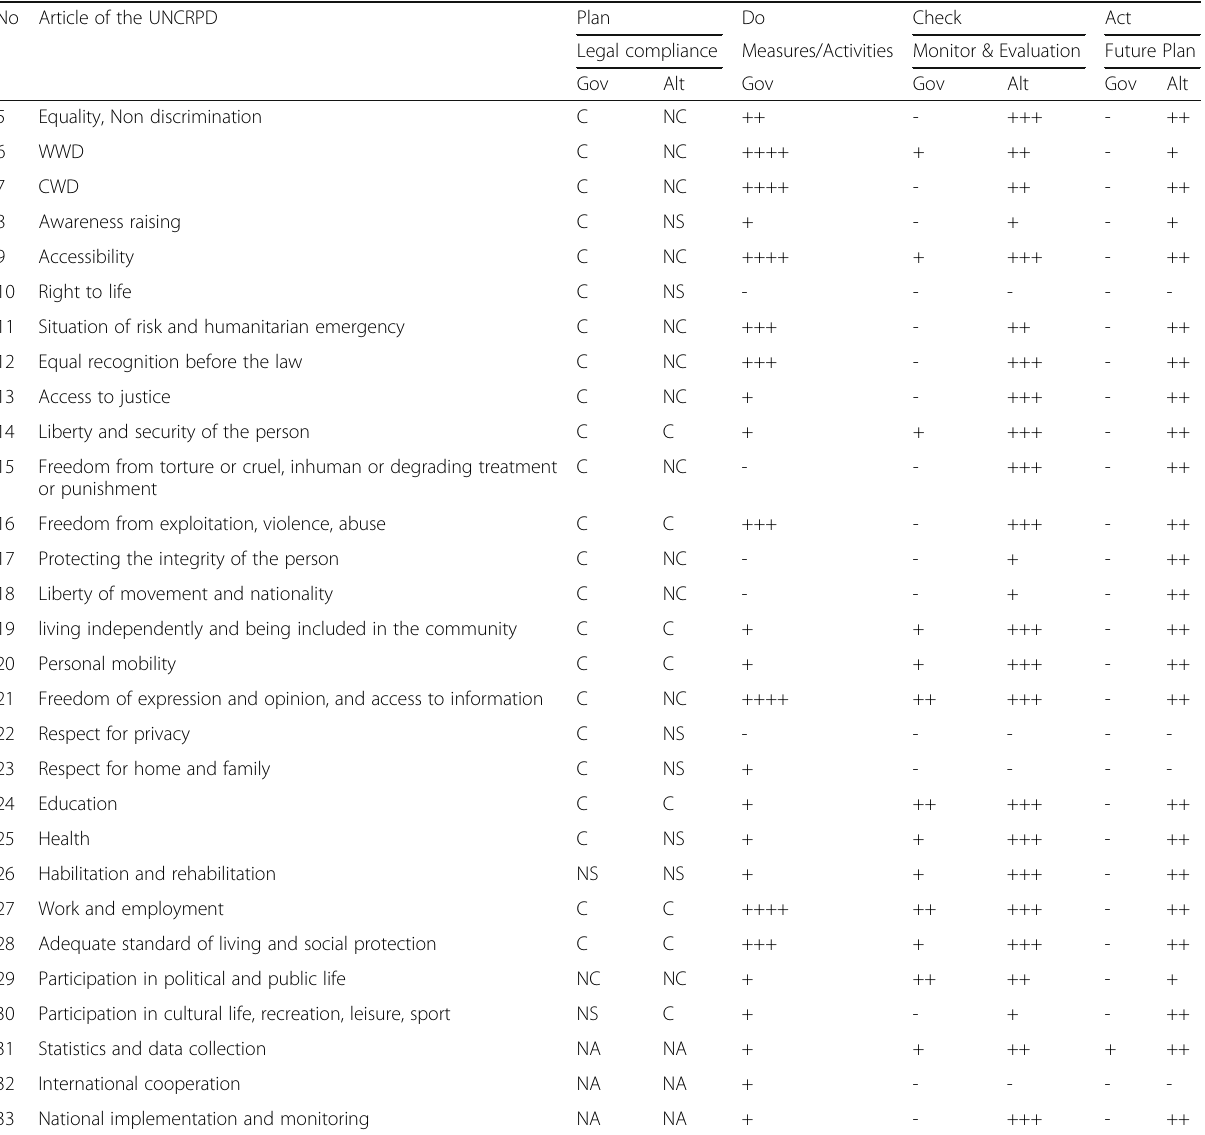
Table 3 Finding